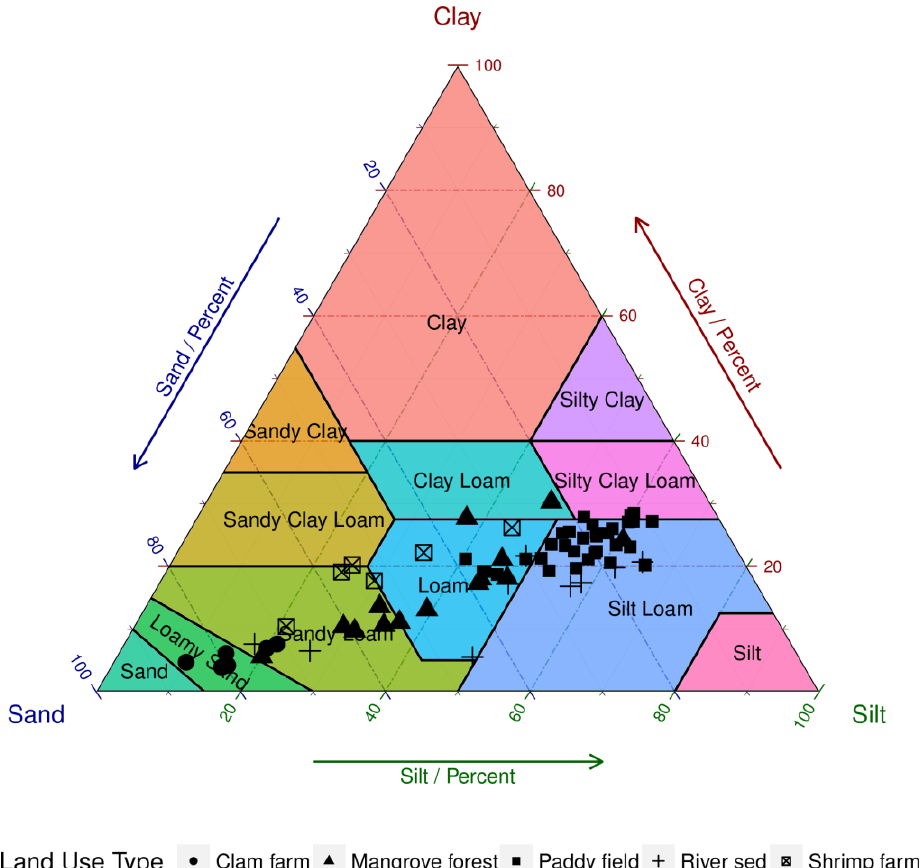
Figure 2. Soil texture of all soil samples based on United States Department of Agriculture (USDA) textural classes.